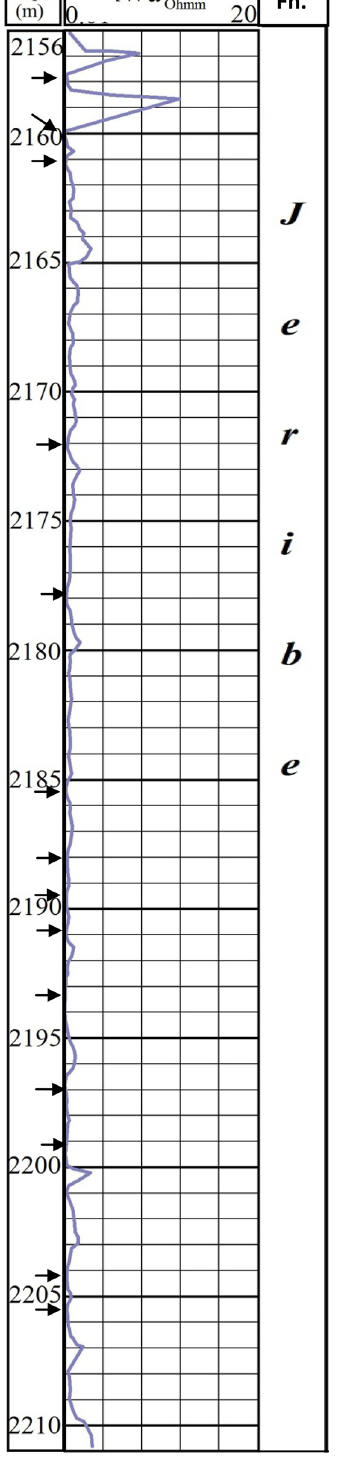
Fig. 4 R wa and R o , R xoo , and R t presentation as QLM for determin- ing water- and hydrocarbon (residual and movable)-bearing zones for Jeribe Formation in the well Ja-49 (black arrows are water-bearing or lowest hydrocarbon-bearing